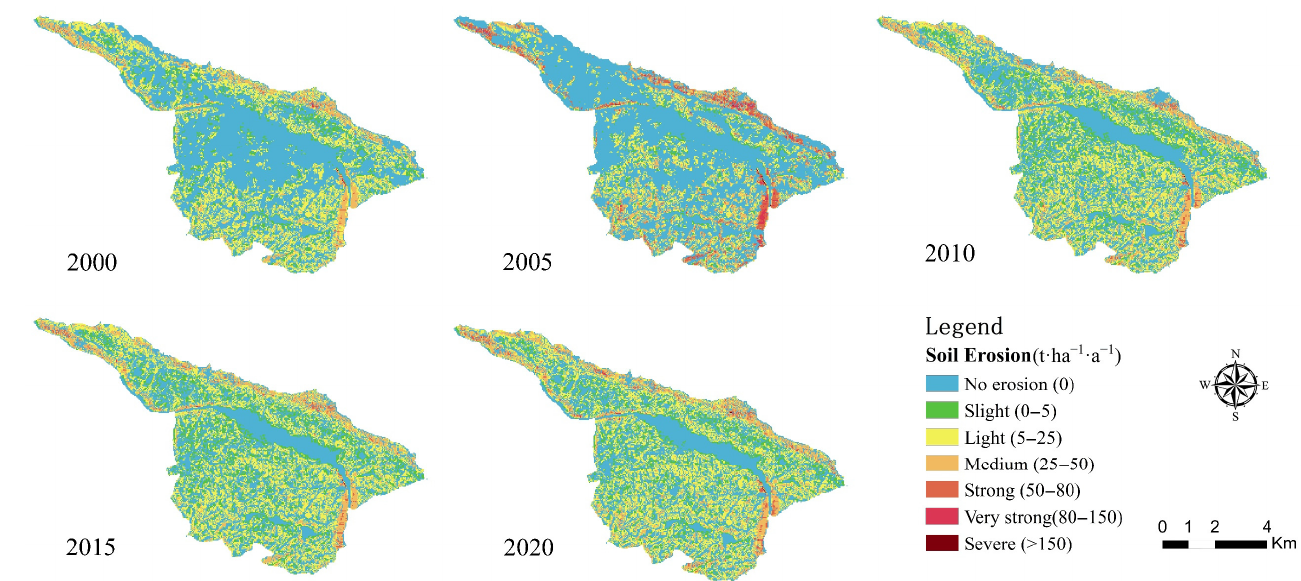
Figure 3. Spatial and temporal characteristics of soil erosion in 2000–2020.